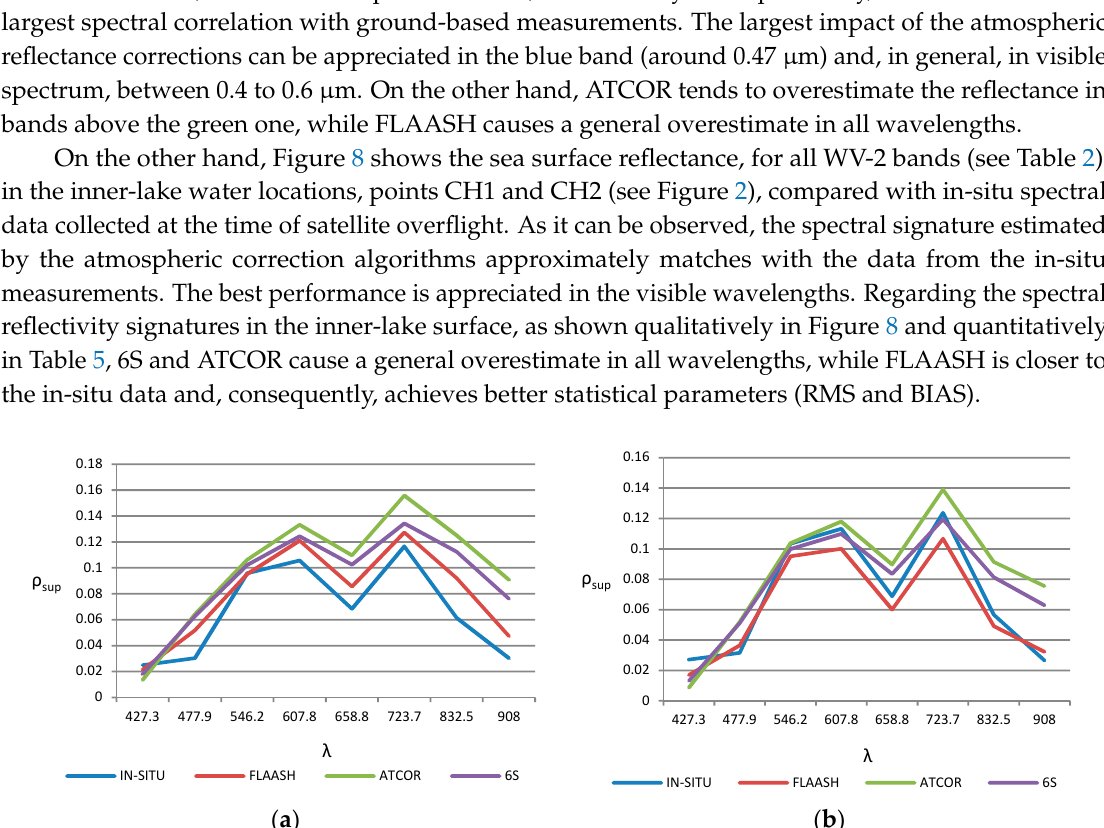
Figure 8. Spectral reflectivity signatures: ( a ) Inner-lake point CH-1 and; ( b ) Inner-lake point CH-2. Table 5. Confusion Matrix using ground truth.